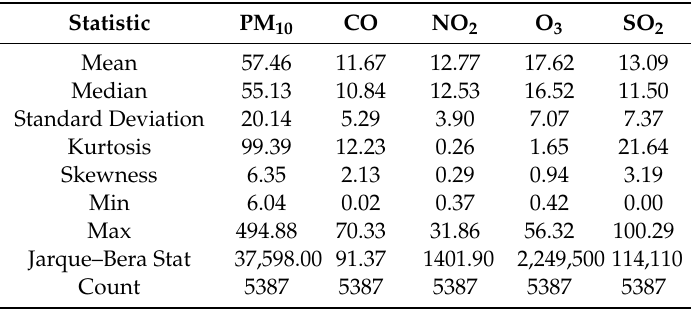
Figure 2. Time series plot for the relative daily fluctuation of each pollutant variable. Table 1. Descriptive statistics for datasets 1, 2, 3 and 4.